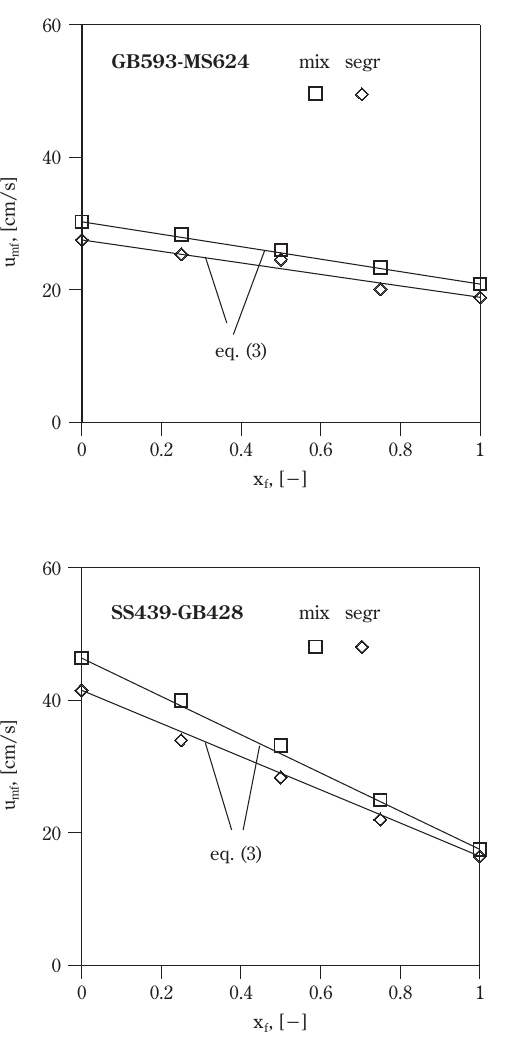
Fig. 4 Size segregating mixtures. Dependence of the minimum fluidization velocity on